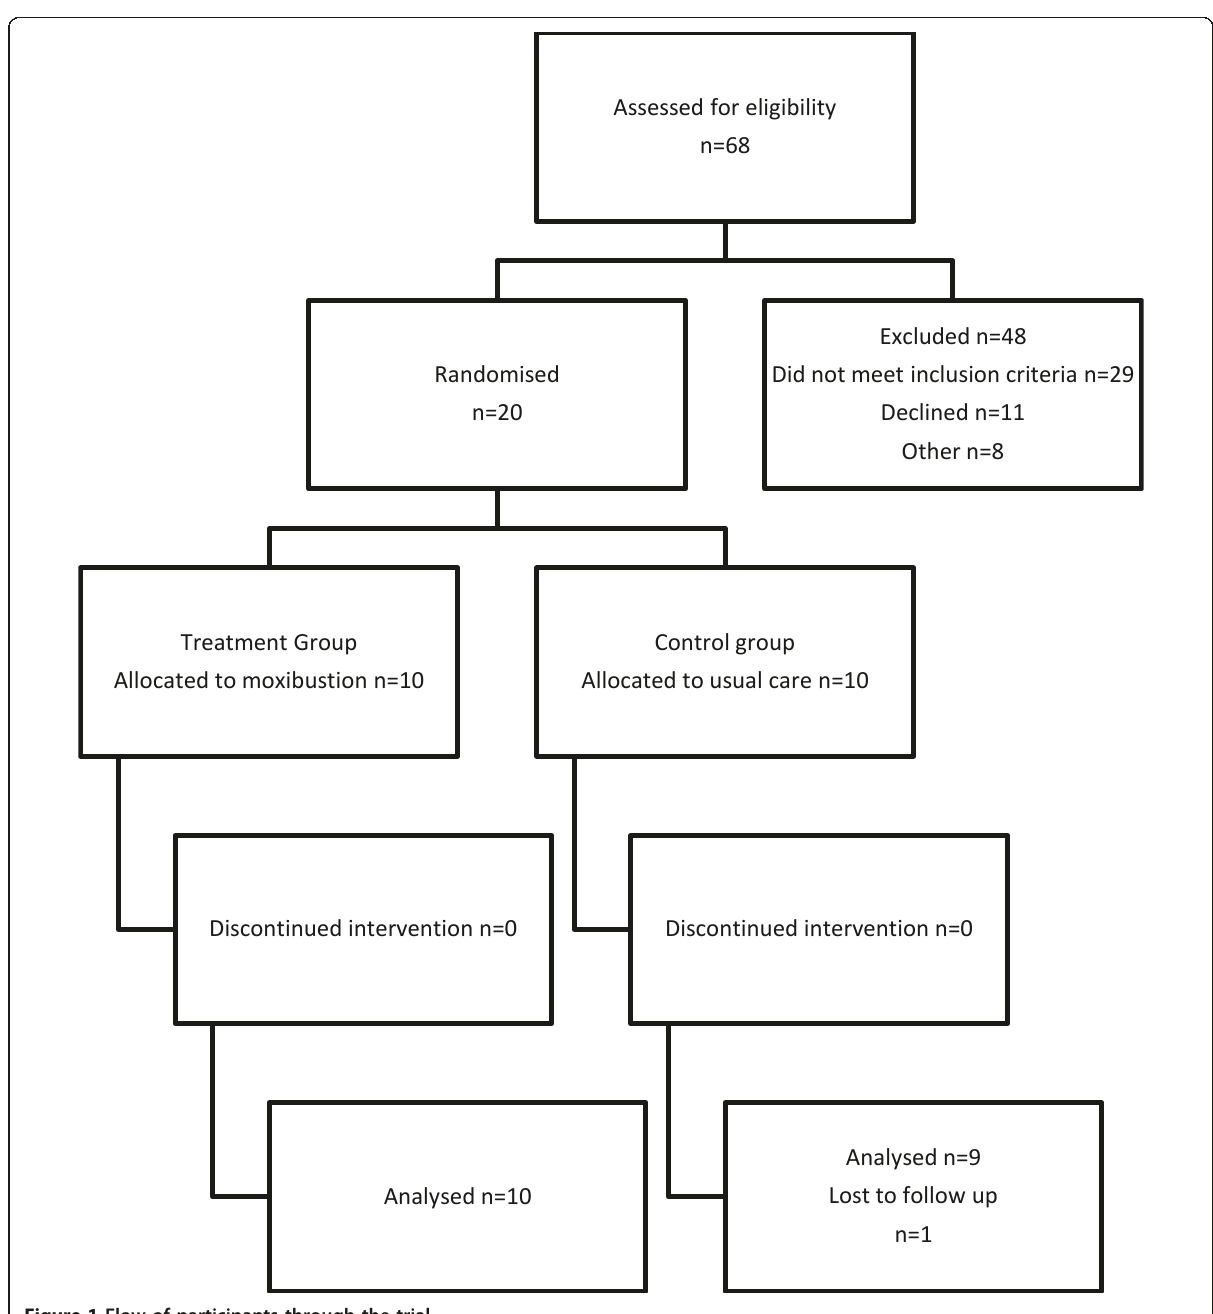
Figure 1 Flow of participants through the trial